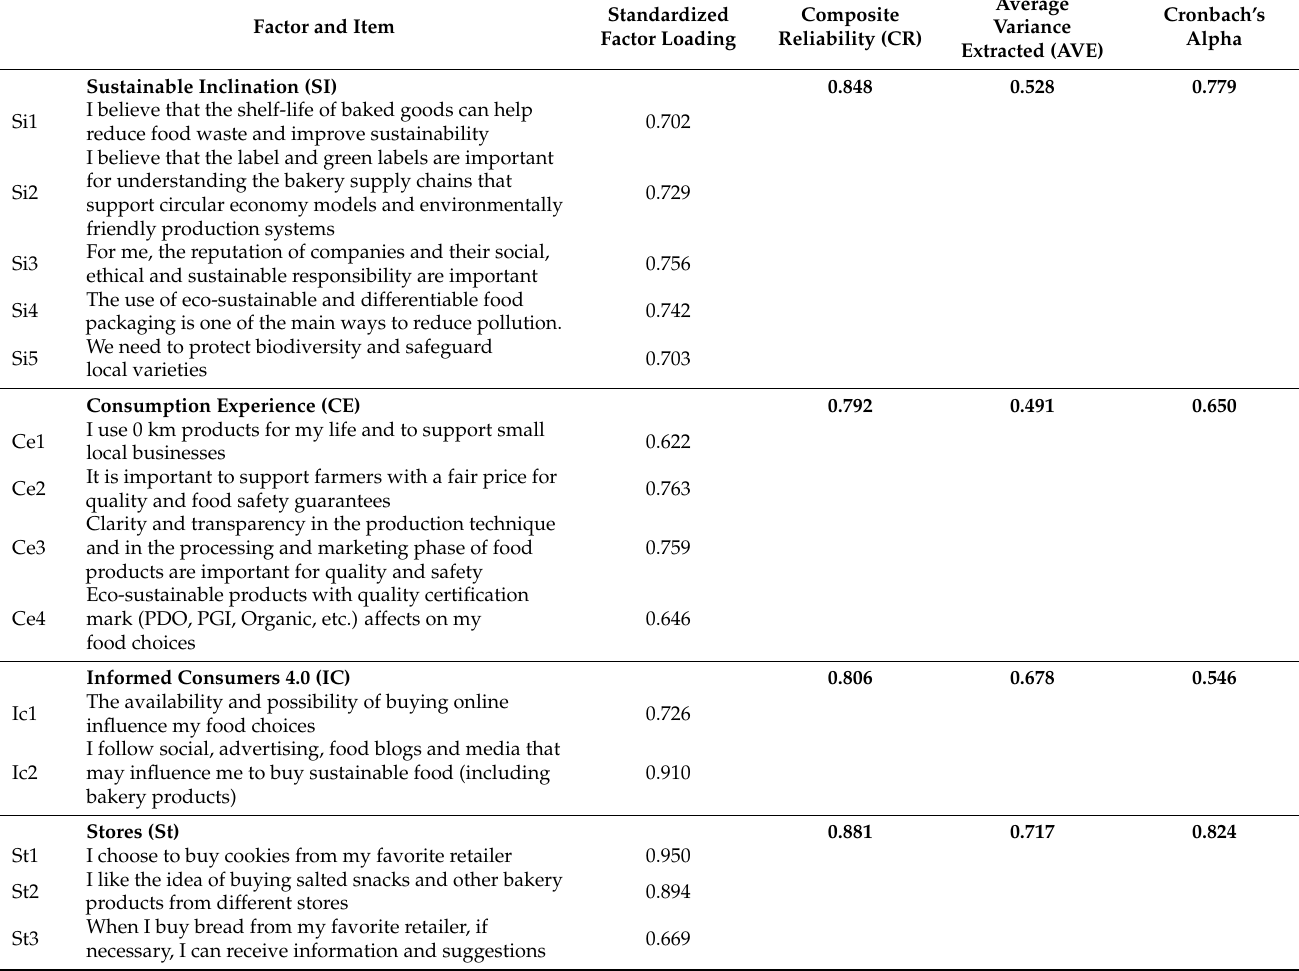
Table 4. Standardized factor loading Composite Reliability (CR) Average Variance Extracted (AVE) and Cronbach’s